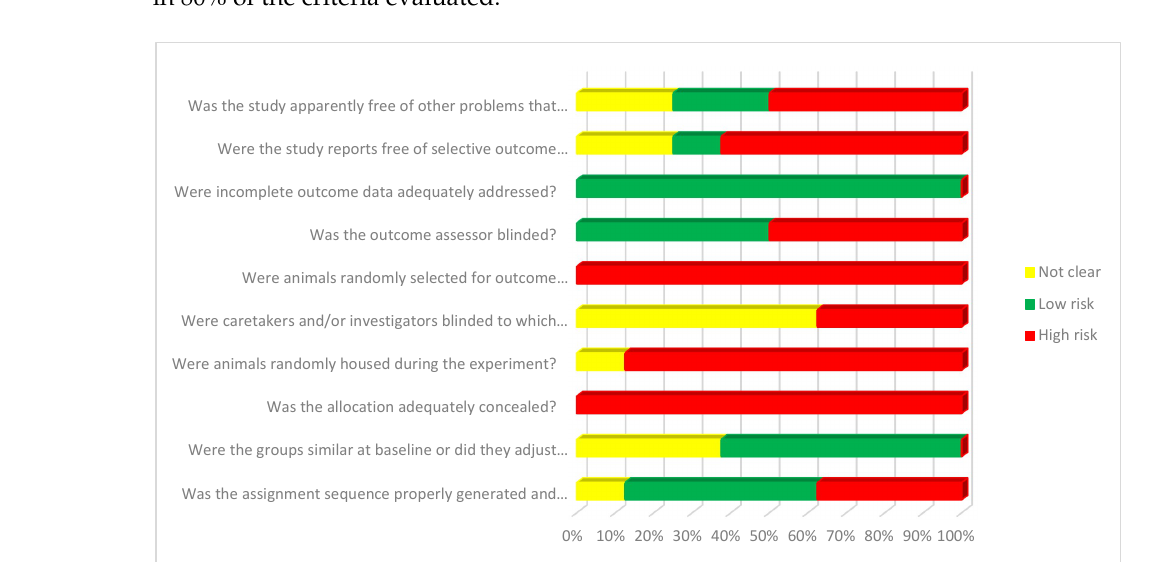
Figure 2. Risk-of-bias summary for each of the included studies ( n = 8). The green color indicates low risk of bias; the yellow color indicates an unclear risk of bias, and the red color indicates high risk of bias.